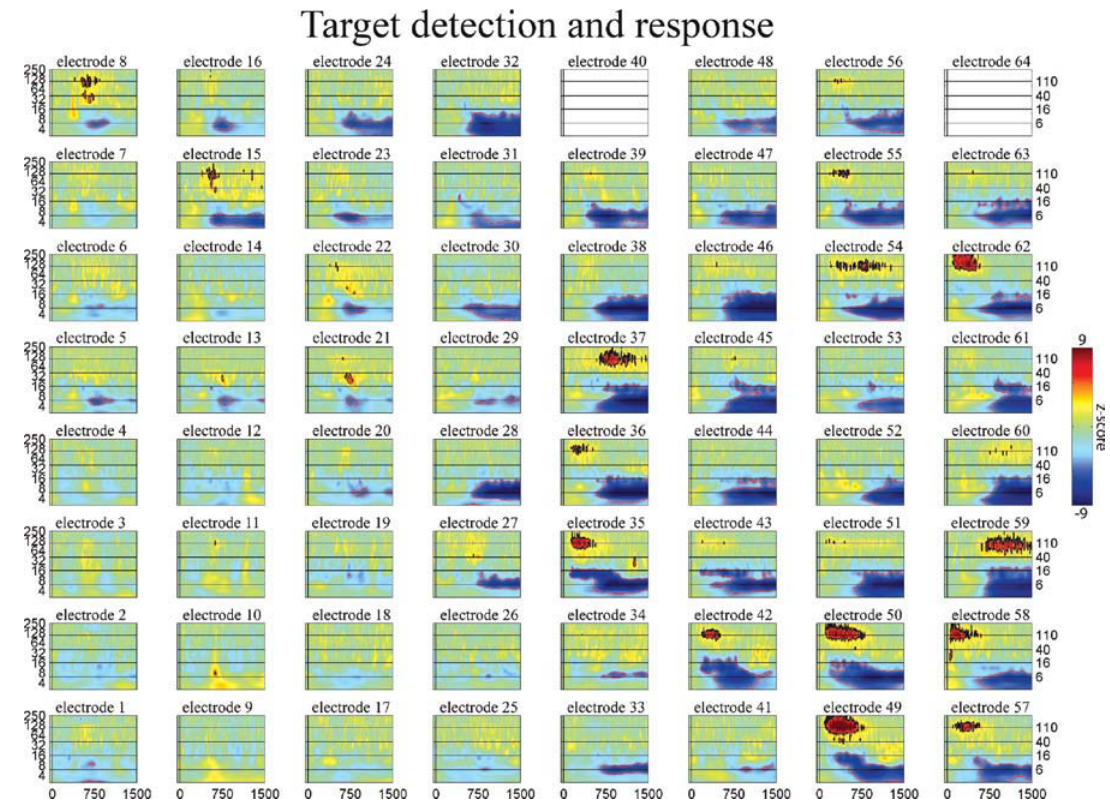
Figure 7. Event-related time–frequency plots for all electrodes in subject A in response to presentation of proper names (targets in target detection task). Note HG activity in electrodes 8 and 15 over prefrontal cortex. See Figure 4A and methods for electrode locations. Vertical lines indicate stimulus onset and offset. Horizontal lines indicated frequencies of interest (theta, beta, low gamma, and HG). Outermost black (red) contour line indicates significant power increase (decrease) (p<0.001, FDR corrected). See also legend for Figure 5.